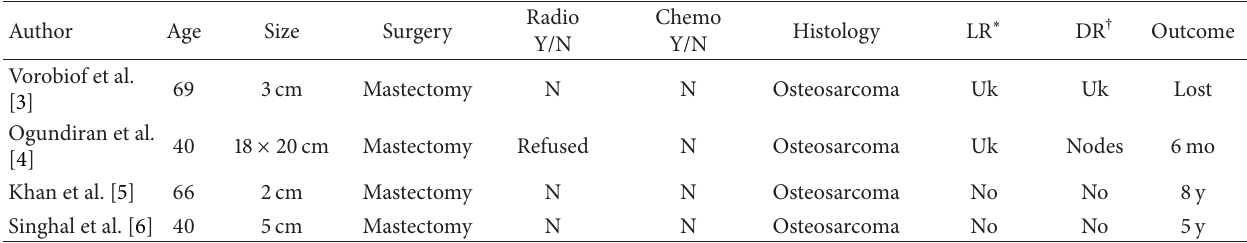
Table 1: Some case reports reported in our